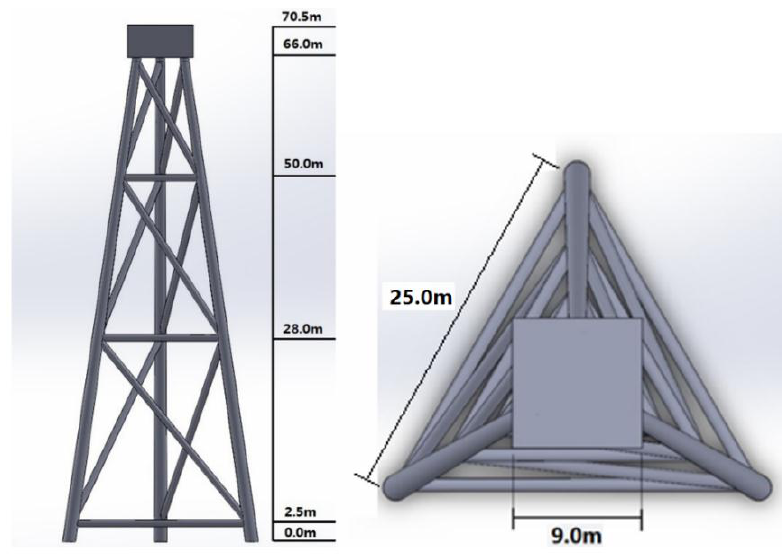
Figure A7. Side and top views of the Z-Tripod (PJZ) structure.